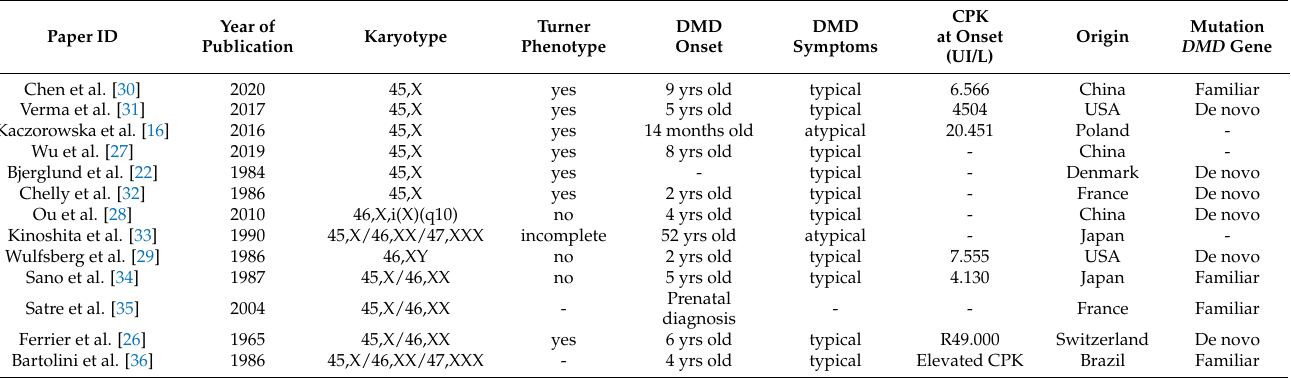
Table 1. All cases of Turner and Duchenne syndrome which have been documented in the literature since the